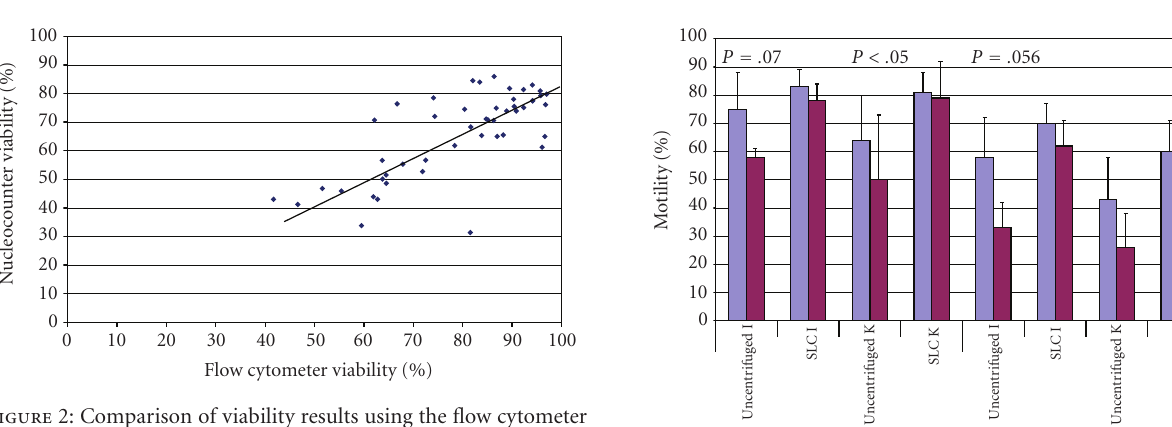
(Table 1). The mean values for the kinematics of SLC- selected spermatozoa were better than the unselected ones for samples in INRA96 at both time points ( P < . 001), but were only significant at 24 hours for samples in Kenney’s extender. The mean kinematic values for the ejaculates from one stallion are shown in Figure 3 as an example. As in the previous experiment, the results for sperm con- centration measured by the Nucleocounter SP-100 and the ( r = 0 . 84; P < .